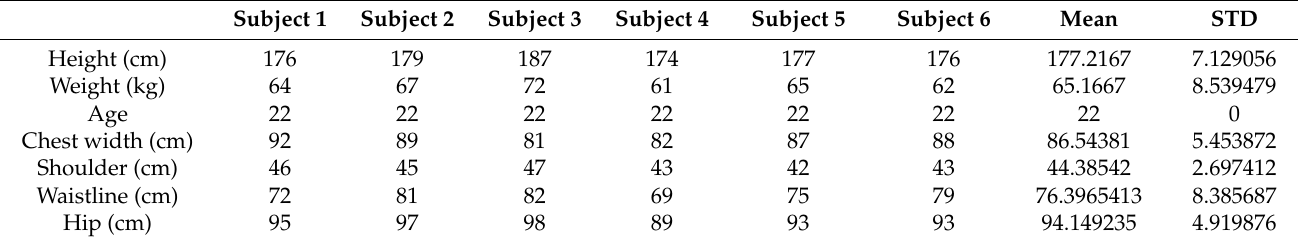
Table 1. Anthropometric measurements of participants.